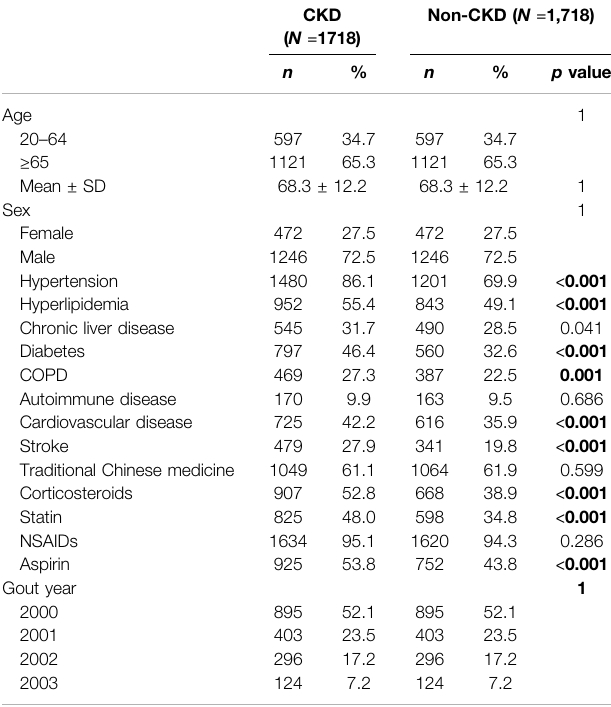
TABLE 1 | Demographic characteristics of CKD and